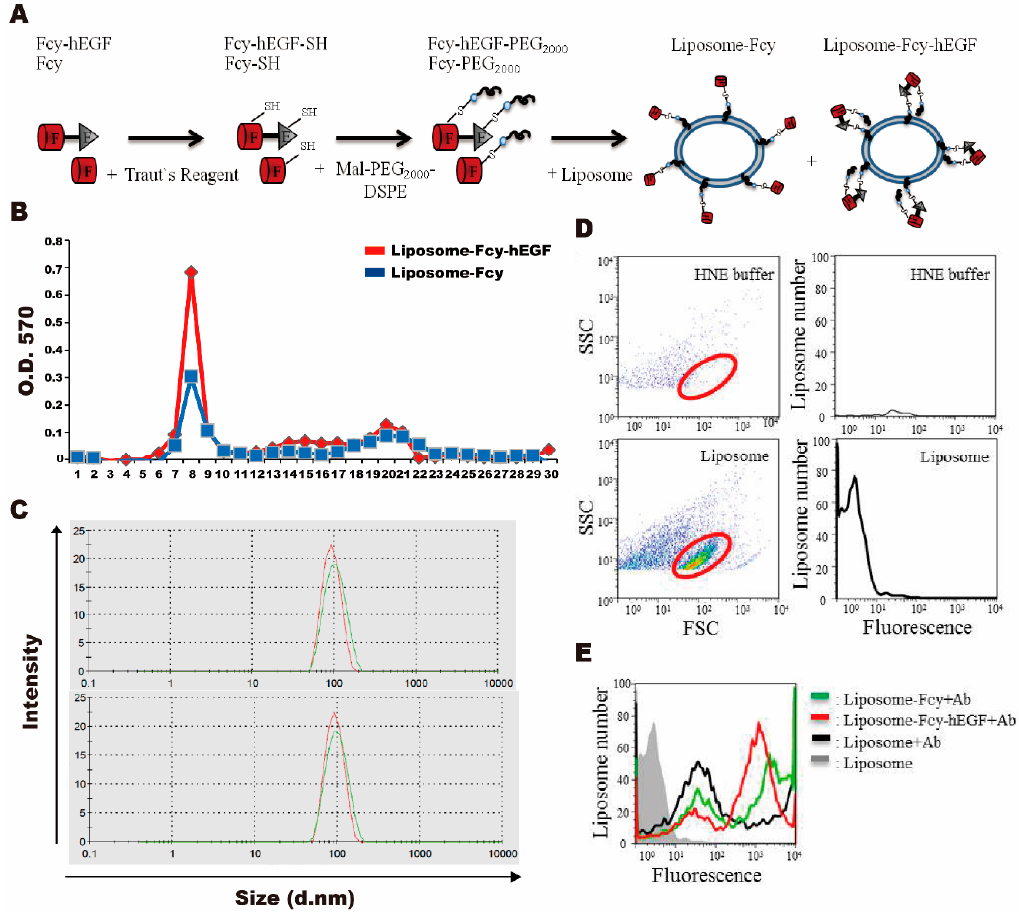
Figure 2. Preparation and characterization of liposome-Fcy-hEGF and -Fcy. ( A ) Fcy-hEGF and Fcy were reduced by Trout’s reagent to synthesis the thiol-conjugation of Fcy-hEGF-SH and Fcy-SH, and then conjugation with maleimide-PEG2000-DSPE to synthesis the pegylated Fcy-hEGF and Fcy, which were further inserted onto the liposome surface. ( B ) Size exclusion of liposome-Fcy-hEGF (red line) and liposome-Fcy (blue line) was mediated by sepharose TM 4B column. ( C ) The size analysis of liposome (red line of top and bottom panel), liposome-Fcy-hEGF (green line of top panel) and liposome-Fcy (green line of bottom panel) by nano-ZS size analyzer. ( D ) Flow cytometric analysis of HNE buffer and liposome for gating the liposome particles (red cycle). ( E ) Flow cytometric analysis of liposome without antibody staining (gray line) was as negative control, whereas liposome (black line), liposome-Fcy-hEGF (red line) and -Fcy (green line) were stained with Fluorochrome-conjugated anti-myc antibody.